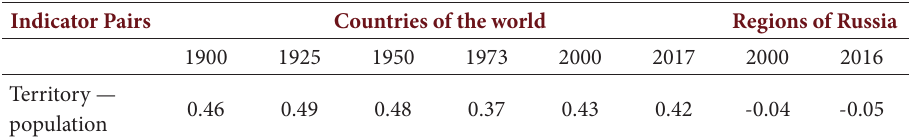
Table 2. Correlation coefficients between territory, population size and GDP for 110 countries of the world of permanent composition and 80-82 regions of Russia